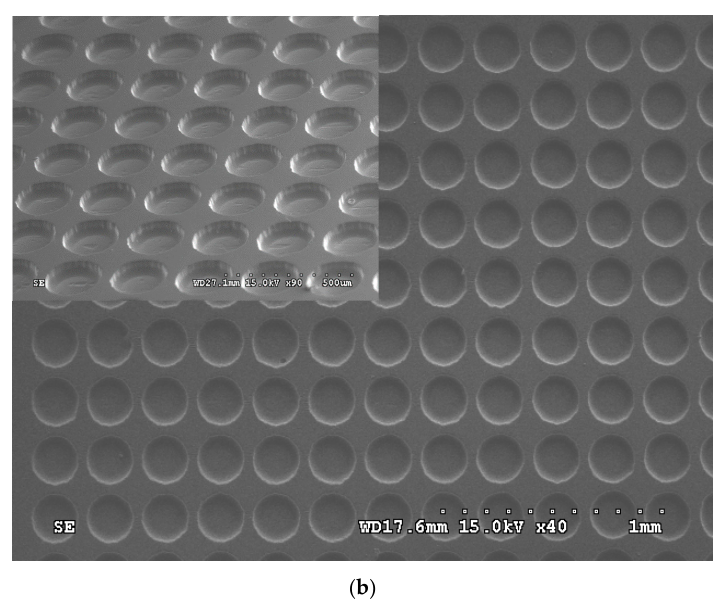
Figure 12. Extrusion film and belt rolling complementary microstructural array. ( a ) Numerical simulation prediction diagram and ( b ) SEM diagram.